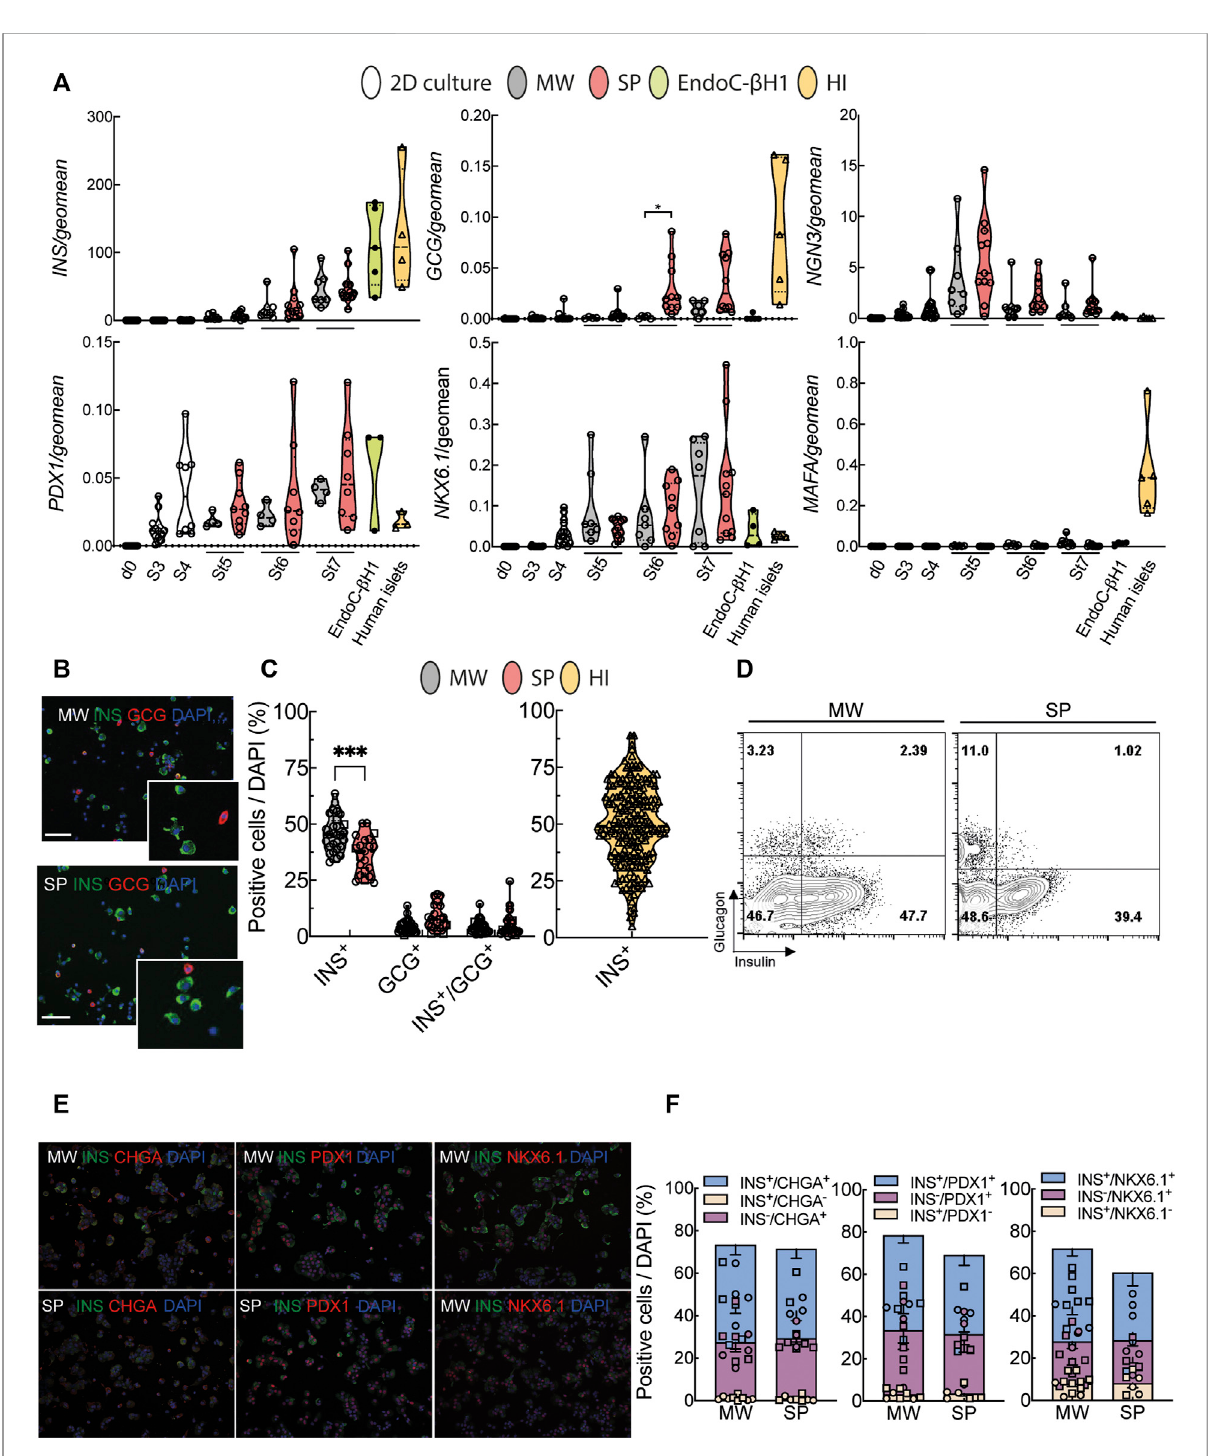
FIGURE 2 Characterization of human iPSC-derived islet-like organoids. (A) , Differentiation markers were measured by quantitative RT-PCR. White bars represent cells until stage 4 (St4, 2D culture), grey bars represent microwell aggregates (MW), red bars suspension aggregates (SP), green bars EndoC- β H1cellsandyellowbarshumanislets(HI). (B) ,Representativepicturesofdispersedaggregatesstainedforinsulin(green)andglucagon(red). NucleiarevisualizedwithDAPI(blue). (C) ,Quanti fi cationofinsulin(INS),glucagon(GCG)andinsulin/glucagon(INS/GCG)expressingcellsfrom immunochemicalanalysis(MWn=29;SPn=22,HIn=205). (D) ,Representative fl owcytometryanalysisofdispersedMWandSPaggregatecells. (E) , Representative pictures of dispersed aggregate cells stained for insulin (green) and chromogranin A (CHGA), PDX1 or NKX6.1 (all in red). (F) , Quanti fi cation of immunochemical analyses of cells expressing insulin only (yellow), chromogranin A, PDX1 or NKX6.1 only (purple), and both (blue)